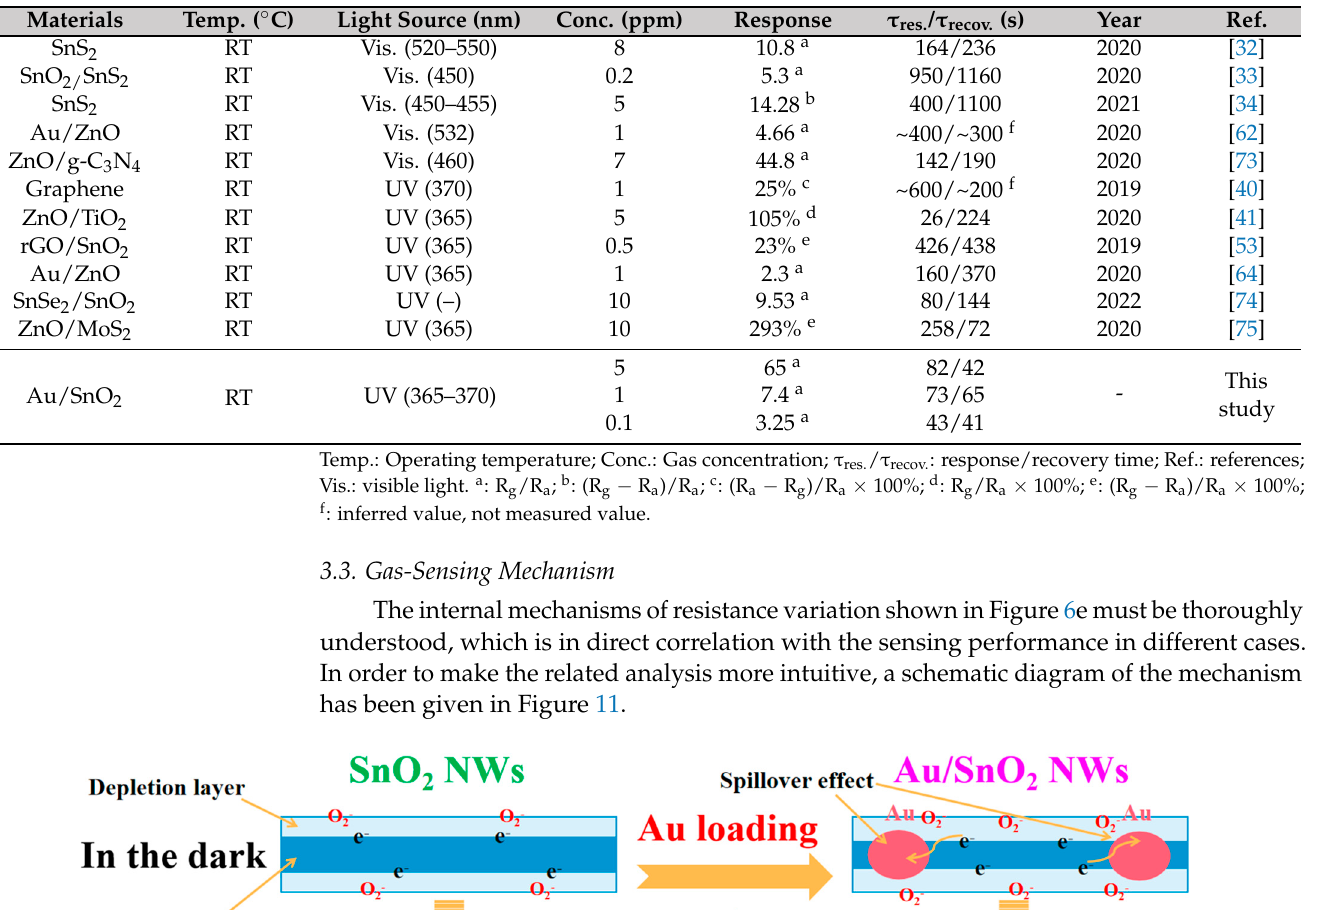
Table 2. A comparison of RT NO 2 sensing performance from the sensor developed in this study and those in other studies.